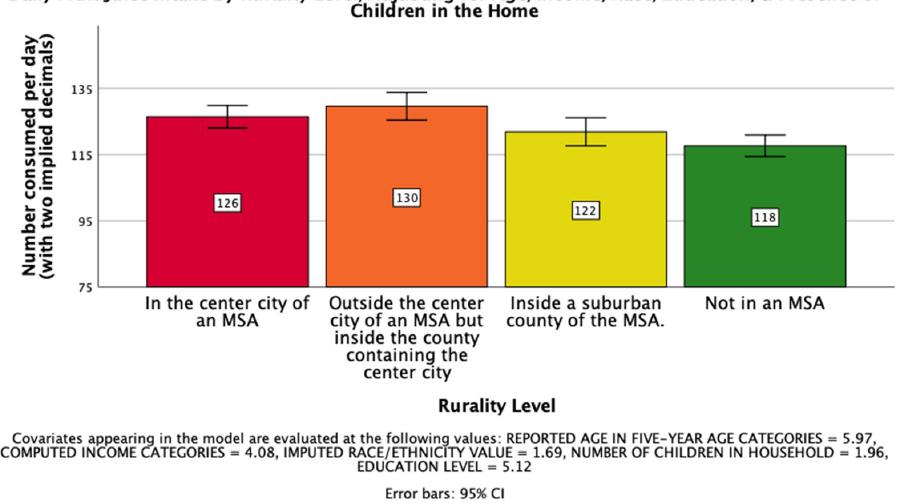
Figure 1. National Mean Daily Fruit Juice Intake.